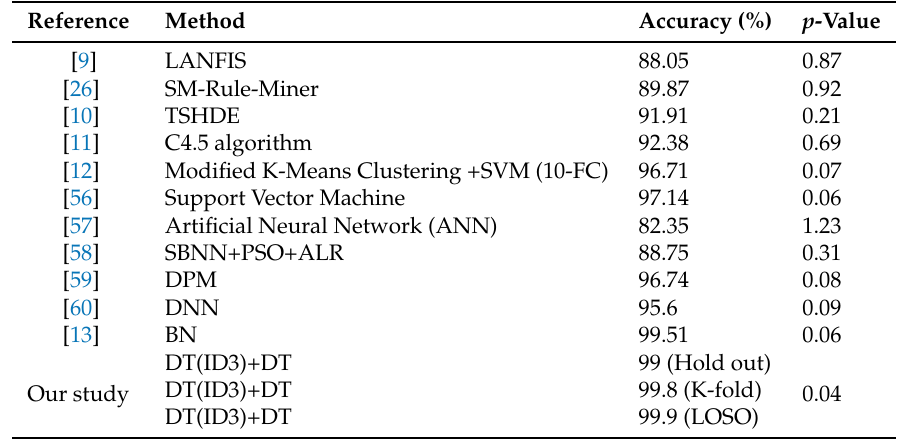
Table 8. Performances comparison of the proposed method with previous methods on the diabetes